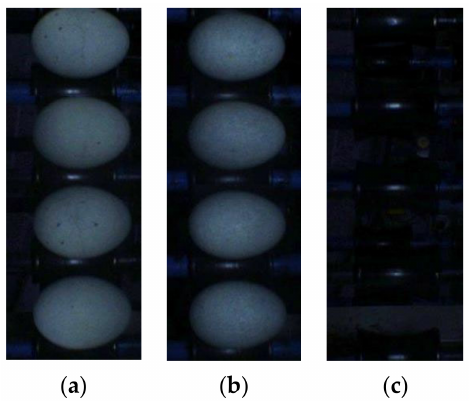
Figure 6. The clipping process of the images of preserved eggs.